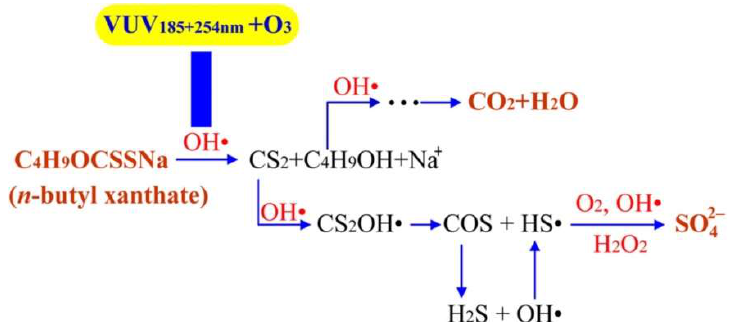
Figure 3. Decomposition pathway of n-butylxanthate in the VUV/O 3 process (reproduced from Process Saf. Environ. Prot. 2016, 102, 64−70 with permission from Elsevier) [16].